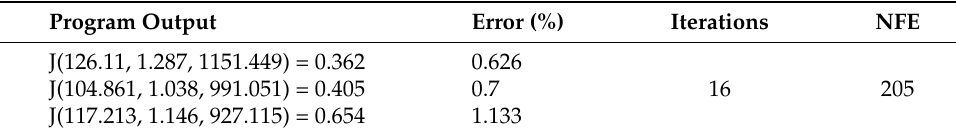
Figure 11. Results of the algorithm for parameter set II: ( a ) below threshold (22), ( b ) functional (21). Note that in many industrial problems, much higher error is tolerated. If the stopping criteria ε 1 is increased from 1 e − 8 to 1 e − 3, and the following parameter set is used for MBC: n = 1, m = 2, d x = 6, d y = 0.06, d z = 20, δ = 1, sb = 20, abb = 20, abp = 5, τ = 3, ε 1 = 10 − 3 , ε 2 = 1, the following results are obtained; see Table 10. Table 10. Results for increased stopping